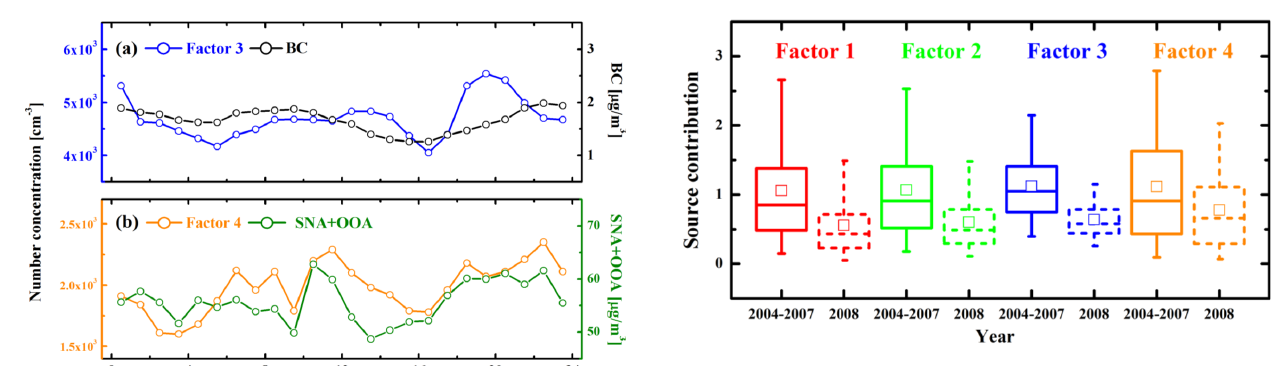
Figure 9: Box plots of the source contributions from 2004 to 2007 (Solid) and 2008 (Dashed) for 4 factors. Source 784 Fig. 9. Box plots of the source contributions from 2004 to 2007 (solid) and 2008 (dashed) for 4 factors. Source contribution values contribution values are normalized. The upper and lower boundaries of boxes indicate the 75th and 25th 785 are normalized. The upper and lower boundaries of boxes indicate percentiles; the line within the box marks the median; the whiskers above and below boxes indicate the 95th and 786 the 75th and 25th percentiles; the line within the box marks the 5th percentiles; and square symbols represent the means. 787 median; the whiskers above and below boxes indicate the 95th and 5th percentiles; and square symbols represent the